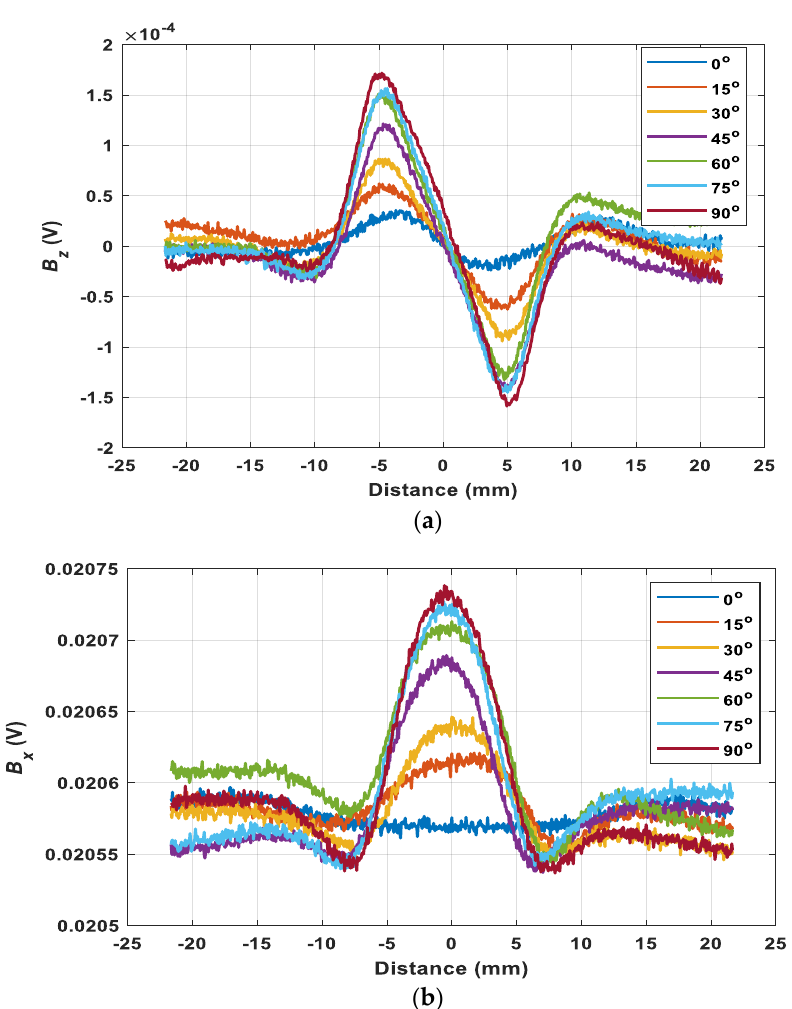
Figure 12. The measurement results of the magnetic field under the rotation angle from 0° to 180° ( a ) the z component, ( b ) the x component.